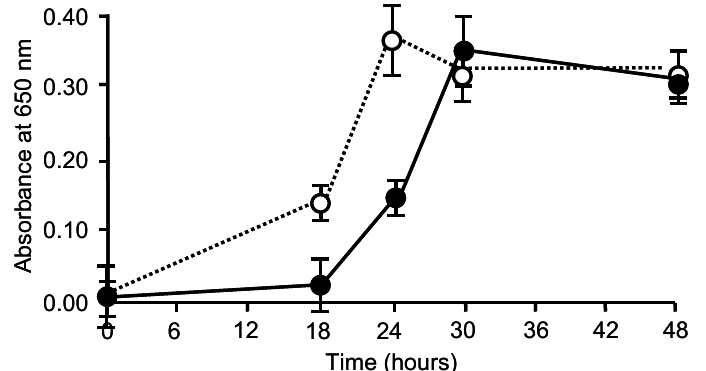
Figure 8. Delay of bacterial growth by addition of AKL. S. pyogenes cells (10 3 /mL) were incubated with (solid line) or without (dotted line) 2 mg/mL AKL. Growth was assessed based on turbidity (absorbance at 650